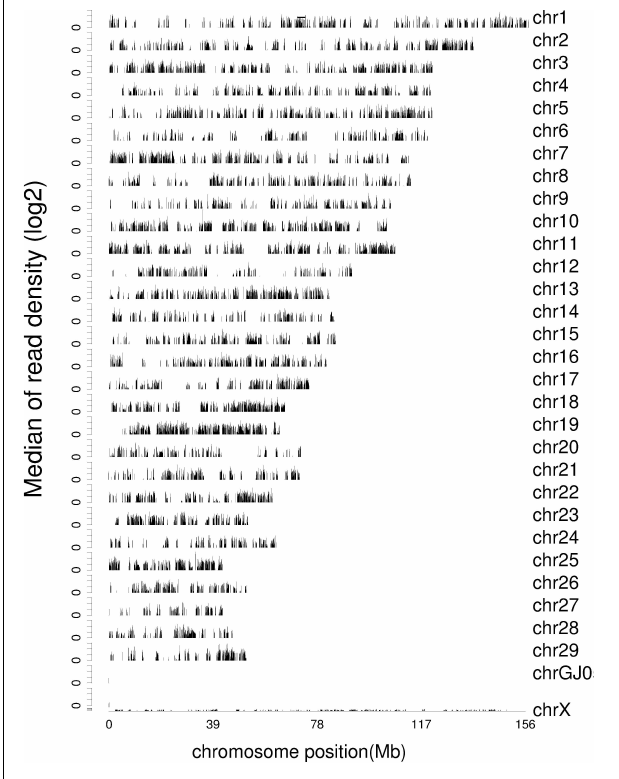
FIGURE 1 | Density distribution map of reference sequence. The abscissa is the position of the chromosome, and the ordinate is the median of read density